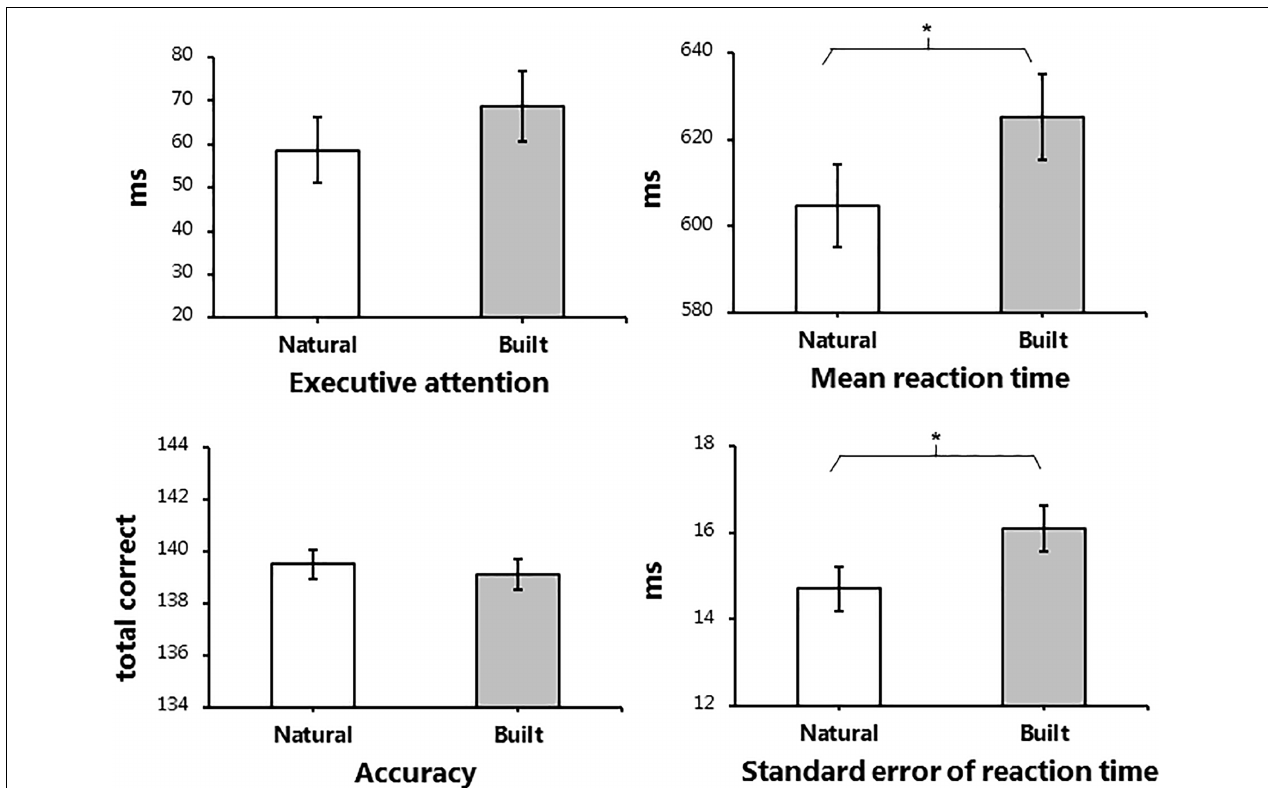
FIGURE 4 | Adjusted post-walk data for performance of the Attention Network Task. Adjusted means and standard errors of the initial base model applied during linear mixed model analysis for the four outcome measures of the Attention Network Task. The post-test data displayed in the figure were adjusted using baseline data as a covariate. Subject was included in the base model as a random factor. ms: milliseconds. Significant main effects of environment are marked, ∗ p <